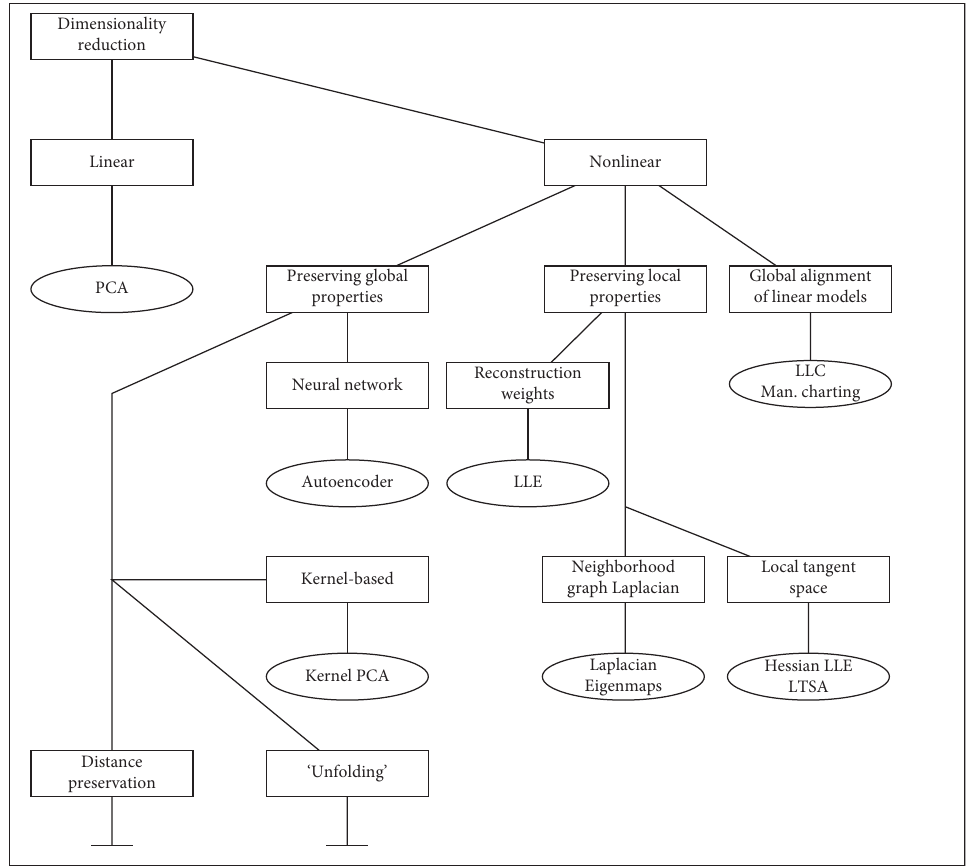
Figure 1: Categorization of dimensionality reduction approaches (Van Der Maaten et al. [8]).